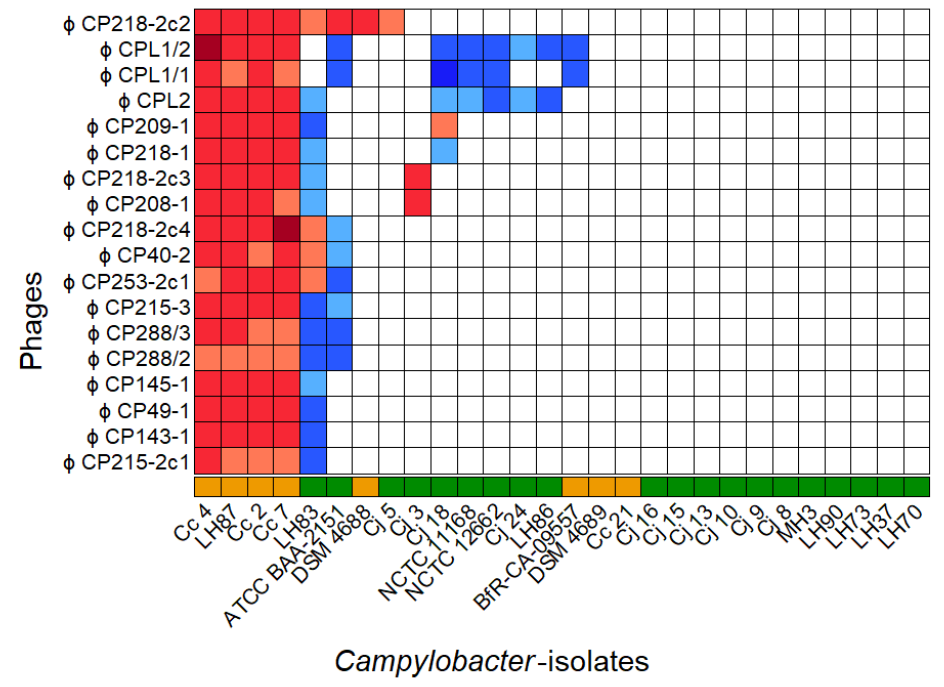
Figure 1. Host range of 18 C. coli -specific phages on 28 Campylobacter isolates with color-coded EOP values. Host range evaluation was performed by spotting serial dilutions of bacteriophages onto NZCYM–soft-agar overlays containing the respective bacterial isolate ( ◼ C . jejuni , ◼ C . coli ). Experiments were performed in triplicate. C. coli 084610 was used as reference strain, and color coding was used to visualize EOP values (cid:4666)◼ 𝒙 > 1.2, ◼ 1.2 ≥ 𝒙 > 1, ◼ 1 ≥ 𝒙 > 0.9, ◼ 0.9 ≥ 𝒙 > 0.8, ◼